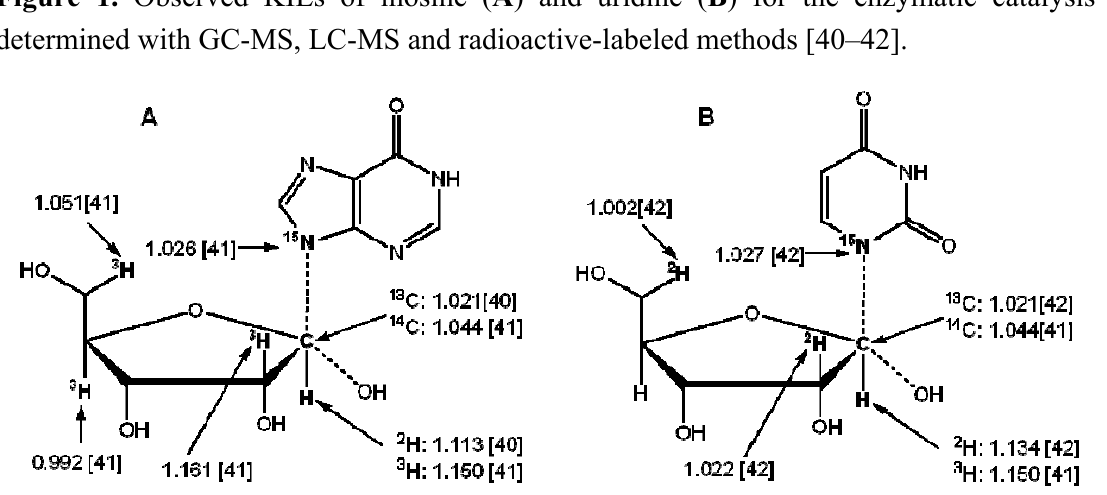
Figure 2. Observed KIEs for UpG and 3 ′ -m-nitrobenzyl phosphate catalyzed by RNase A measure by WMS and IRMS, respectively